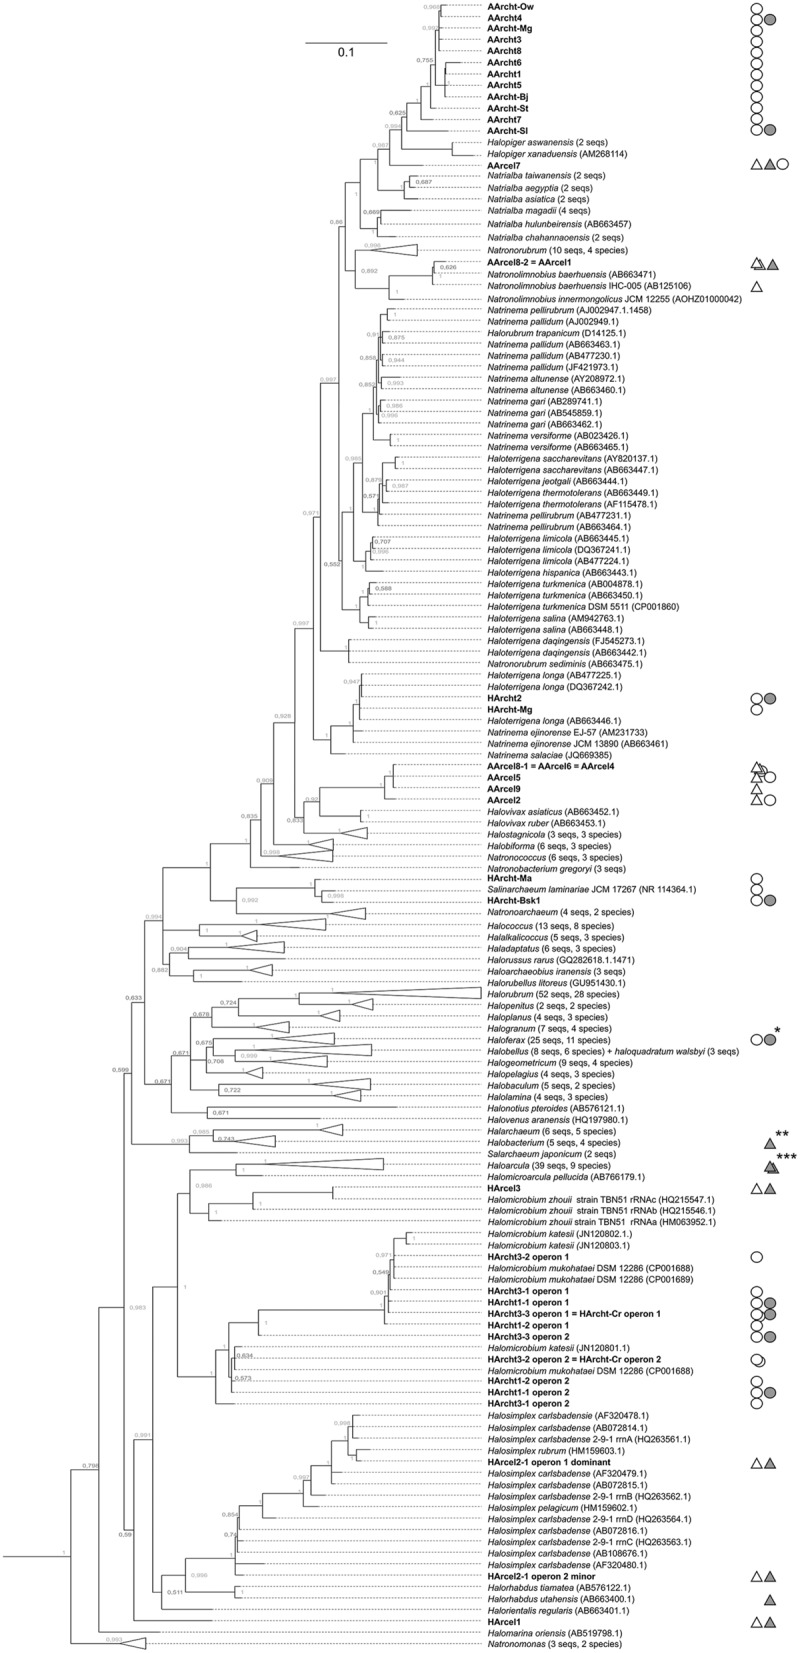
16S rRNA gene-based Bayesian phylogenetic tree showing the position of chitino/cellulolytic strains among haloarchaea. The probability that the associated taxa clustered together is shown next to the branches. The numbers at the nodes indicate the bootstrap values. Bar is 10 nucleotide substitutions per 100. The strains growing on chitin are marked by open circles; the strains with characterized chtinolytic activities/chitinases are indicated by solid circles; the strains, growing on insoluble cellulose are indicated by open triangles; the strains with characterized cellulolytic activities/cellulases are indicated by solid triangles. ∗Haloferax mediterranei ATCC 33500; ∗∗Haloarcula sp. LLSG7 and Haloarcula sp. G10; ∗∗∗Halobacterium salinarum NRC-1.